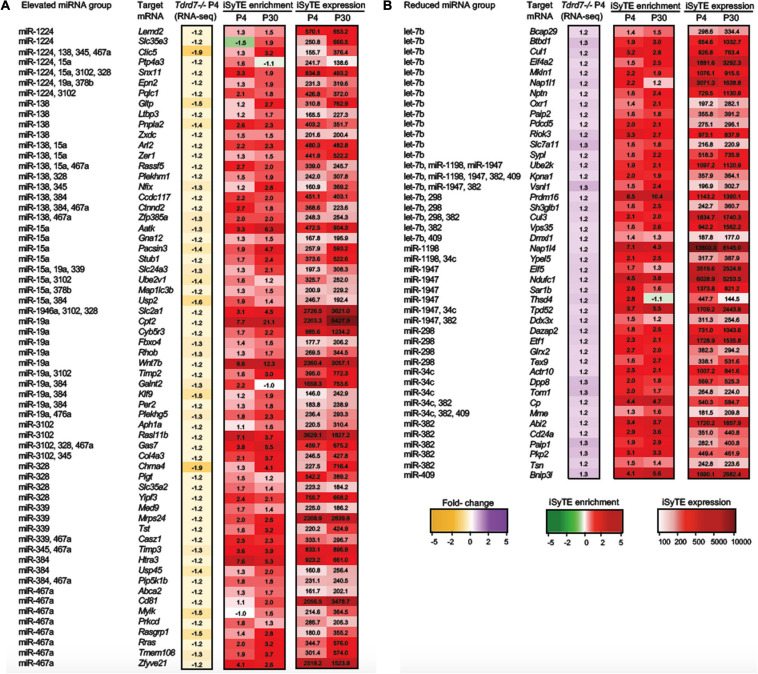
“Promising” mRNA targets of Tdrd7-downstream miRNAs in the lens. Heat-maps representing expression of “Promising” mRNA targets of miRNAs identified in (A) “Elevated miRNA group” and (B) “Reduced miRNA group” in Tdrd7-/- lens. The mRNAs identified as “Promising” targets in the “Elevated miRNA” group are identified as reduced in Tdrd7-/- P4 RNA-seq, and are lens-enriched at P4 and/or P30. In the “Reduced miRNA” group the “Promising” targets are identified as elevated in Tdrd7-/- P4 RNA-seq and are lens-enriched at P4 and/or P30. Heatmap keys indicate the following: Yellow and purple color gradient represent low to high differential expression in Tdrd7-/- lens compared to control lens (in Fold-change) in RNA-seq data. Green and red color gradients represent low to high lens-enrichment (in Fold-change) in iSyTE microarray data at P4 and P30. Light-red and red gradients represent low to high lens-expression (in fluorescent intensity units) in iSyTE microarray data at P4 and P30.